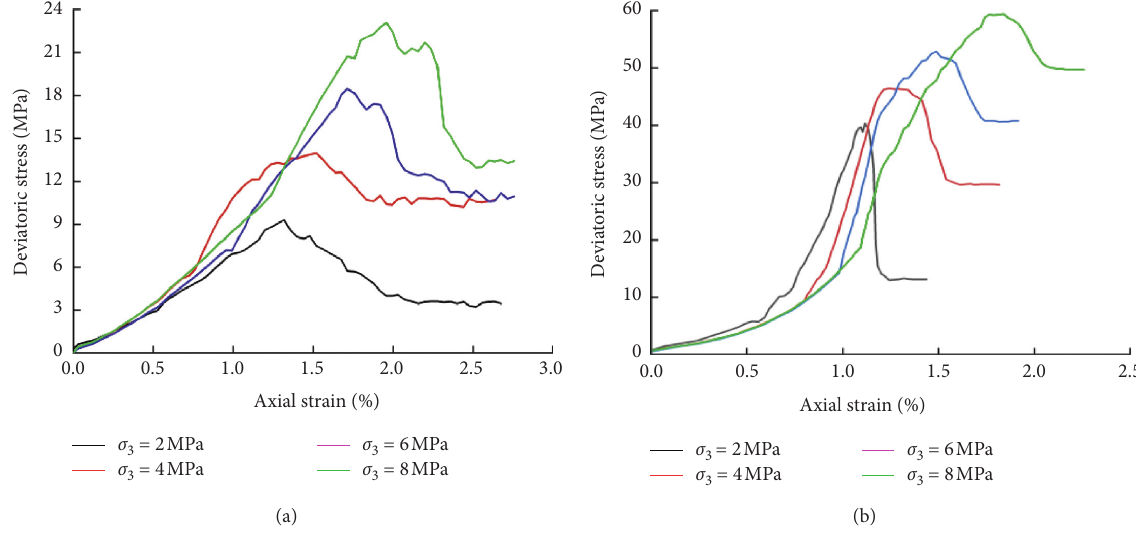
Figure 7: Conventional triaxial stress-strain curves of two rocks. (a) Mudstone. (b) Sandstone.